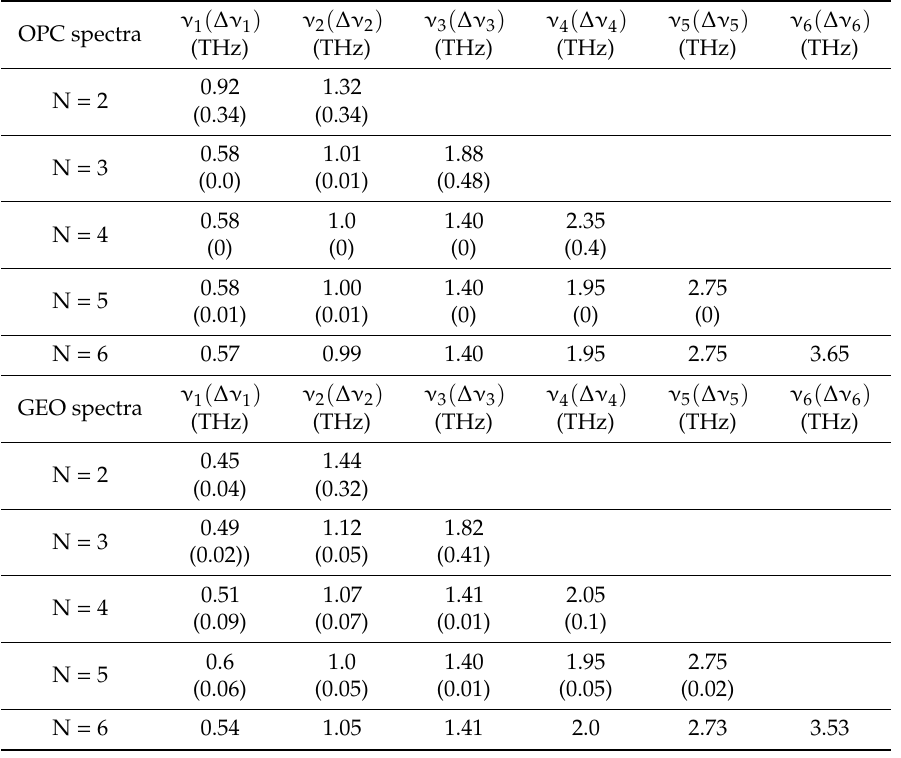
Table A1. Positions of the peaks in terms of the number (N) of used gaussians together with the uncertainty of the